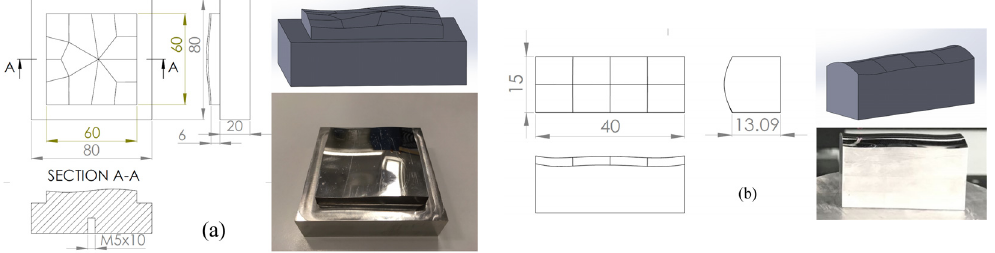
Figure 5. The designed and machined workpieces: ( a ) sinusoidal workpiece; and ( b ) f-theta lens workpiece (unit in mm).